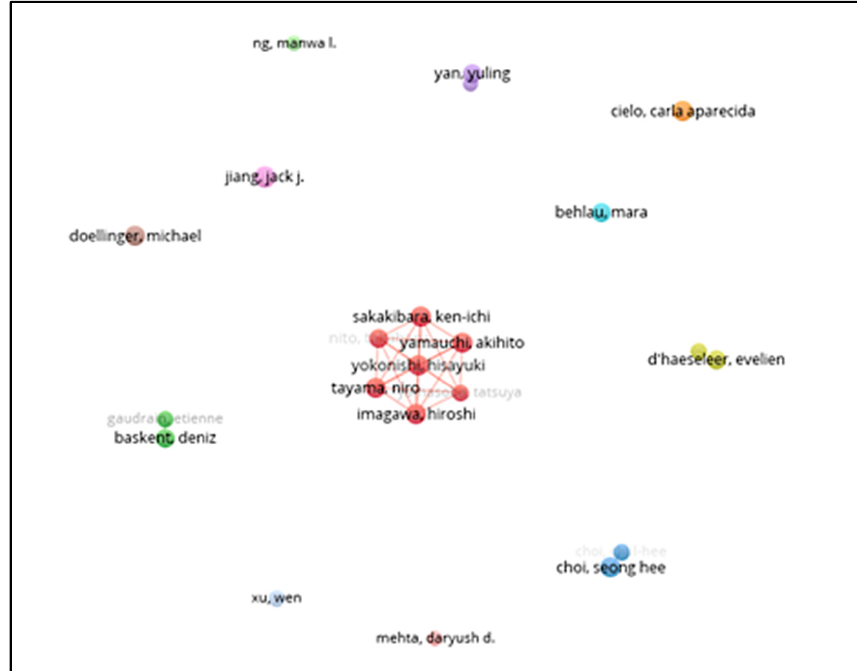
Figure 3. Authors’ network visualization (VOSviewer). Based on data from the most productive authors, established by the aforementioned limits (publications with a maximum of 10 authors and authors with a minimum production of 5 papers).